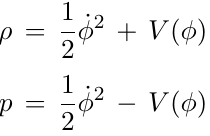
Figure 16 . Dynamical evolution of the lepton number asymmetry N L ( z ) in the case of no hierarchy enhancement, p = 0. Here, the (cid:12)nal lepton asymmetry is determined by the out-of-equilibrium (cid:23) 1 decays, with the gravitational mechanism producing a steep rise in the asymmetry at earlier times for temperatures z . 0 : 01. Here, M 1 = 10 10 GeV, K = 5, with M 2 = 10 12 GeV, Im K 12 = (4 (cid:25) ) 2 = 5 (cid:2) 10 (cid:0) 4 and " 1 = 10 (cid:0) 7